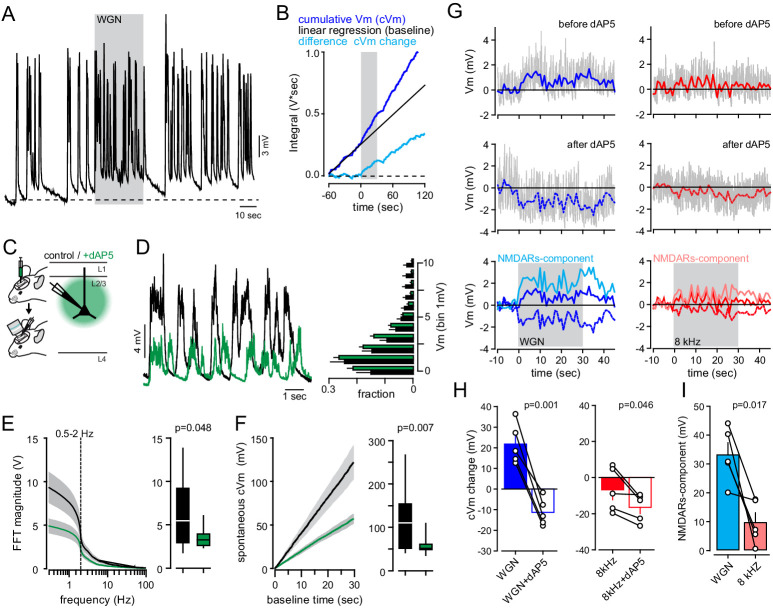
dAP5 application affects spontaneous and auditory-evoked FrA membrane potential changes.(A) Single-cell example of typical spontaneous slow wave fluctuations. (B) WGN-evoked cVm change (light blue) is calculated by subtracting the cumulative Vm (cPSP, blue) by its linear regression during the baseline period (black line). (C) Experimental protocol: L2/3 pyramidal neurons were patched 1 to 5 hr after craniotomy and dAP5 (1 µM) was applied topically and present for the entire duration of the experiment. (D) Left, examples of single-cell spontaneous membrane potential (Vm) fluctuations during anesthesia in controls (black) and upon dAP5 injection (green). Right, mean (±sem) membrane potential probability histograms (control, n = 22; dAP5, n = 19). (E) Left, average (±sem) fast Fourier transform (FFT) of spontaneous membrane potentials in controls (black) and upon dAP5 injection (green). Right, blocking NMDARs significantly decreases the 0.5–2 Hz range (p=0.048, Mann-Whitney rank sum test). Box plot represents median and interquartile range (control, n = 22; dAP5, n = 19). (F) Left, average (±sem) cumulative PSP (cPSP) of spontaneous membrane potentials in controls (black) and upon dAP5 injection (green). Right, blocking NMDARs significantly decreases cVm amplitude after 30 s (p=0.007, Mann-Whitney rank sum test). Box plot represents median and interquartile range (control, n = 22; dAP5, n = 19). (G) Single cell example of Vm fluctuation upon WGN (left) and 8 kHz (right) before and after dAP5 application. Colored bars represent averaged Vm over 1 s time window. The NMDARs-mediated component is calculated by subtracting the averaged Vm before and after dAP5 application. (H, I) Average cVm (±sem) change before and after dAP5 application. Circles and lines, paired cells.Figure 1—figure supplement 2—source data 1.Effect of dAP5 application.